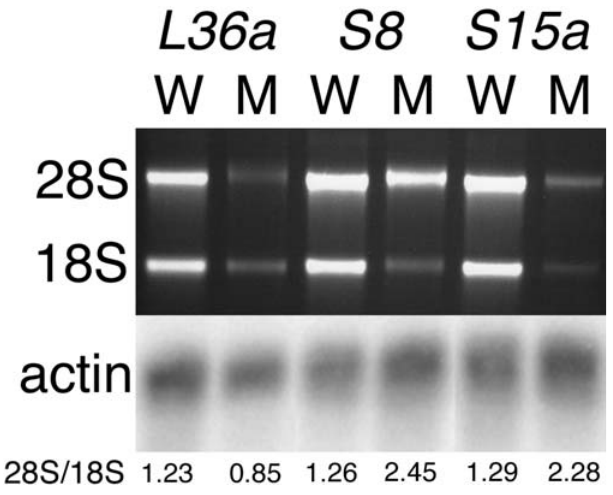
Figure 5. Ribosomal RNA Levels Are Reduced in RP Mutants RNA was prepared from 3-d-old homozygous mutant embryos or their wild-type siblings from lines hi10 (L36a), hi1974 (S8), and hi2649 (S15a), and RNA content was visualized by electrophoresis and ethidium bromide staining. The ratio of 28S/18S as determined by densitometry is shown below each lane. Note that L36a mutants show a preferential loss of the 28S band by 1.5-fold, while S8 and S15a mutants show a preferential loss of the 18S band by 1.9- and 1.8-fold, respectively. These RNAs were also northern blotted and probed